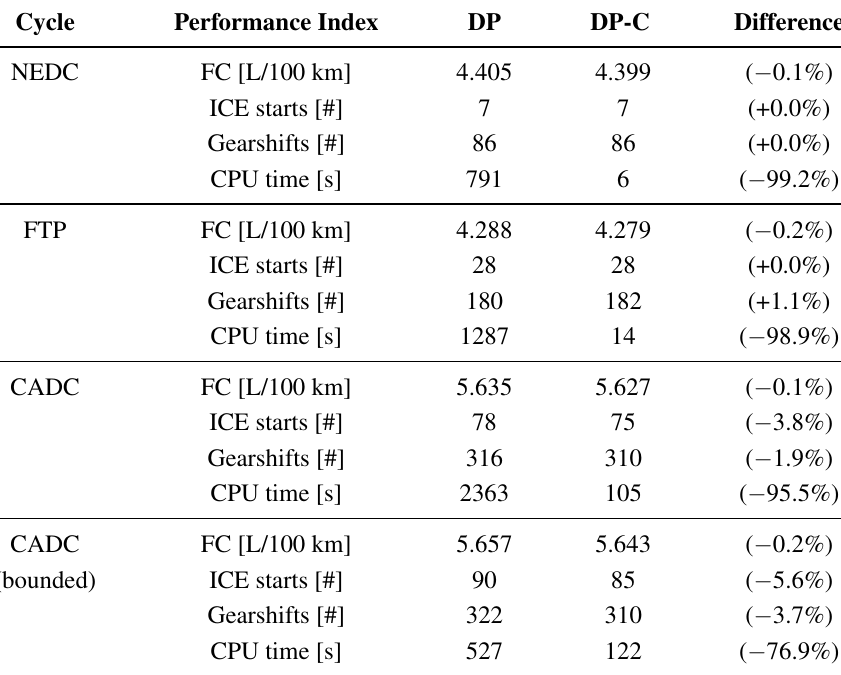
Table 2. Results with the convex vehicle